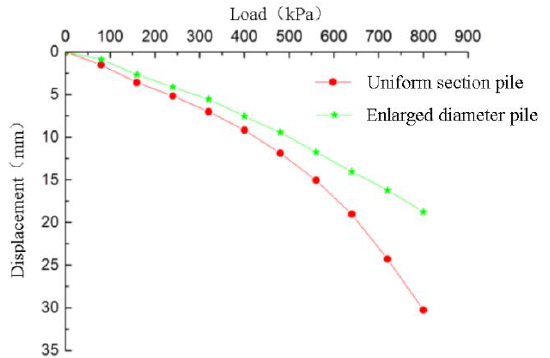
Figure 14. The load settlement curve of two complexes foundations.